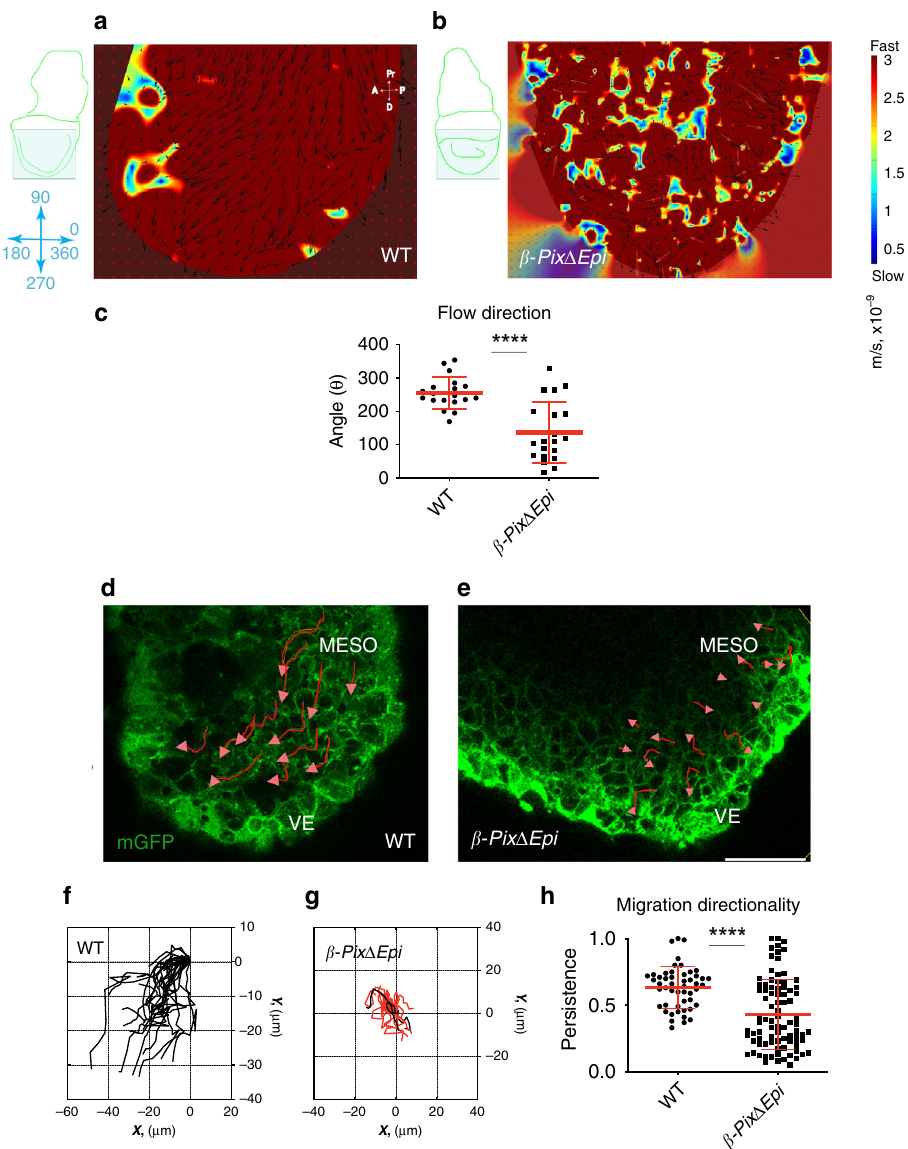
Fig. 2 β -Pix is required in vivo for normal migration of the mesoderm wings. a , b PIV shows defects in global tissue migration in living E7.5 WT and β - Pix Δ Epi mutant embryos. PIV heat maps of velocity magnitude vectors, generated from rendered sagittal confocal time-lapse sections of mesodermal wing of embryos expressing membrane-GFP (mGFP), show directional tissue fl ow in wild-type embryo ( a ) and disruption of the fl ow resulting in a patchy pattern in β -Pix Δ Epi mutants ( b ). 0° is right (posterior), 90° is up (proximal), 180° is left (anterior), 270° is down (distal), and 360° is right (posterior). Embryos were positioned in the same orientation (schematics show embryo outline (green), the area of imaging (blue square) and the angles axis in blue). c In contrast to the vector angles in the wild type (255° ± 48; n = 19, 3 embryos) there is a wider range of vector angles in β -Pix Δ Epi mutants (137° ± 91; n = 20, 3 embryos); mean ± s.d. **** p < 0.0001 (two-tailed Student ’ s t -test and one-way ANOVA). d , e Sagittal confocal time-lapse images of live membrane- GFP embryos show mesodermal wings with overlaid cell migration trajectories (red arrows). d Mesoderm cells move distally and anteriorly in the wild-type embryo. In the absence of β -Pix , mesoderm cells migrate randomly ( e ). f, g Cell migration tracking. Migration of mesoderm cells in wild-type embryo ( f ) is directional and is disrupted in β -Pix Δ Epi ( g ) embryos. h Wild-type cells migrate in a persistent way (0.63 ± 0.2; n = 50 cells, 4 embryos), which is reduced in β -Pix mutant embryos (0.43 ± 0.3; n = 86 cells, 6 embryos); mean ± s.d. *** p < 0.0001 (two-tailed Student ’ s t -test), p = 0.0043 (one-way ANOVA). Scale bar, 50 µ m ( d , e ); m/s ( a , b Thus, individual cell movements parallel the global movement of all moved with an overall anterior trajectory during 1.5 h of the mesoderm layer identi fi ed in the PIV analysis. observation time (Fig. 2d and Supplementary Movie 1), with the cells nearest the streak having the most pronounced anterior β -Pix is required for directional migration of cells in the movement. Wild-type cells maintained a consistent direction over time; the directional persistence in wild-type cells was 0.63 ± 0.2; embryonic mesoderm . In contrast to the steady anterior move- n = 50 cells, 4 embryos (Fig. 2f, h). Individual cell tracking ment seen in wild-type mesoderm (Fig. 2a), PIV showed that cell analysis showed that wild-type cells moved with an average direction was disrupted in β -Pix Δ Epi mutants (Fig. 2b), with migration speed of 1.2 ± 0.27 µm/min ( n = 36 cells, 3 embryos). patches of adjacent cells appearing to move in different